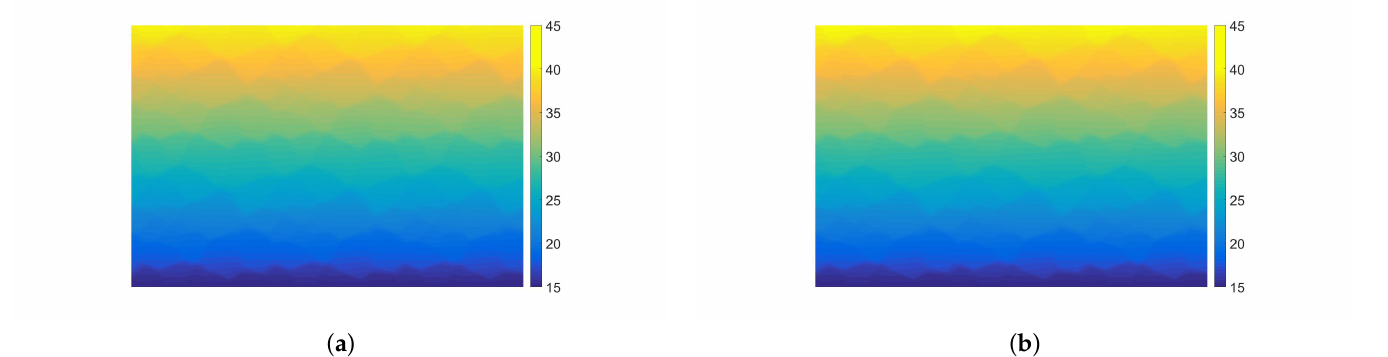
Figure 5. Temperature distribution [°C]: ( a ) direct FEM solution, ( b ) upscaled solution (plotted for p = 5).